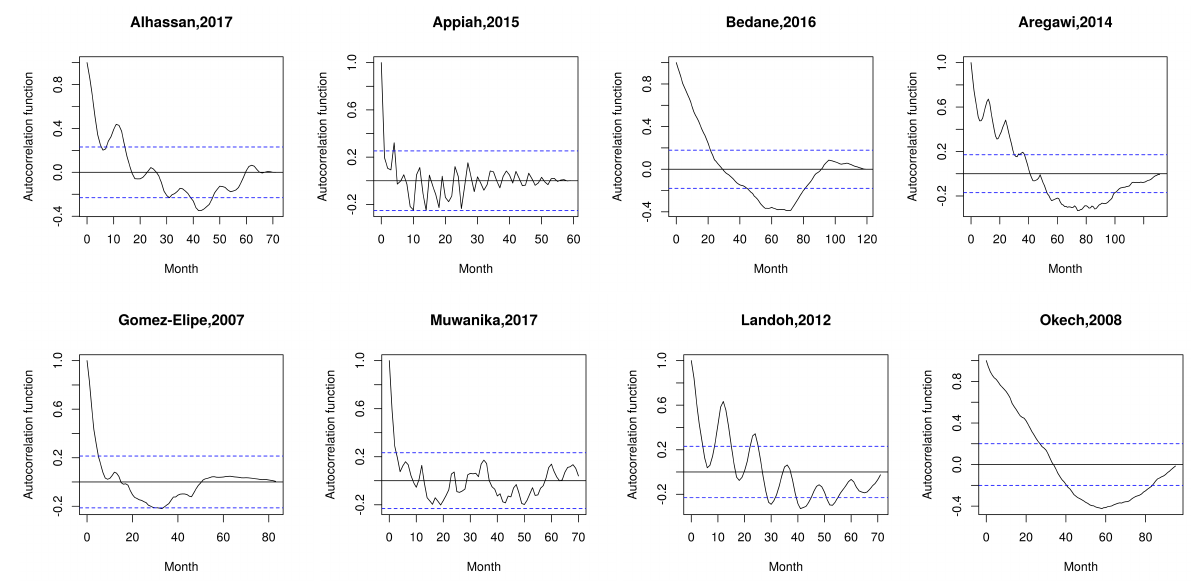
Figure 4. Malaria empirical series: Autocorrelation function from ( a ) Alhassan et al. (Kasena Nankana municipality in Ghana, 2017) [21]. ( b ) Appiah et al. (Ejisu-Juaben municipality in Ghana, 2015) [16], ( c ) Bedane et al. (Kucha district in Ethiopia, 2016) [23], ( d ) Aregawi et al. (Ethiopia, 2014) [22], ( e ) Gomez-Elipe et al. (Karuzi in Burundi, 2007) [24], ( f ) Muwanika et al. (Uganda, 2017) [26], ( g ) Landoh et al. (Est Mono district in Togo, 2012) [25], ( h ) Okech et al. (Kenya, 2008) [27].